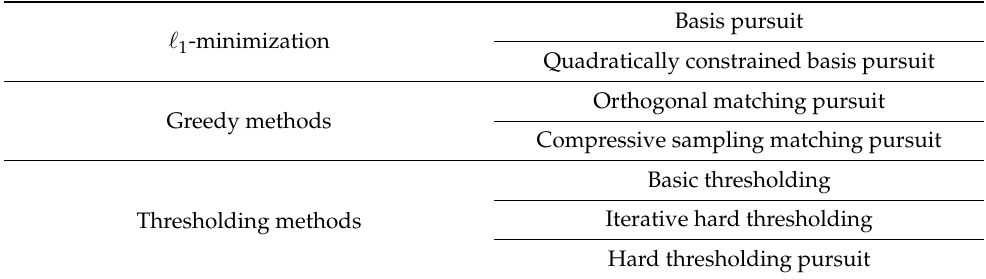
Table 5. Reconstruction